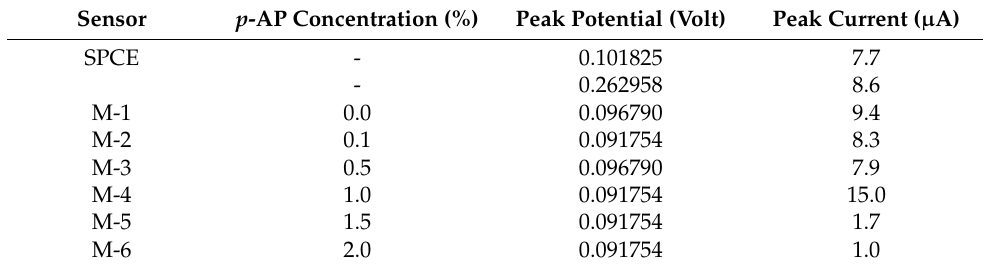
Figure 1. Voltammogram of p -AP 50 µM in buffer solution pH 6.2. Data were obtained from sensors for various p -AP concentrations in the MIP. SWV parameters at potential step 10 mV; frequency 10 Hz; and scan rate 50 mV/s. Table 1. Peak potential and peak current for 50 µM of p -AP solution resulted by several sensors in variation of template ( p -AP) concentration.